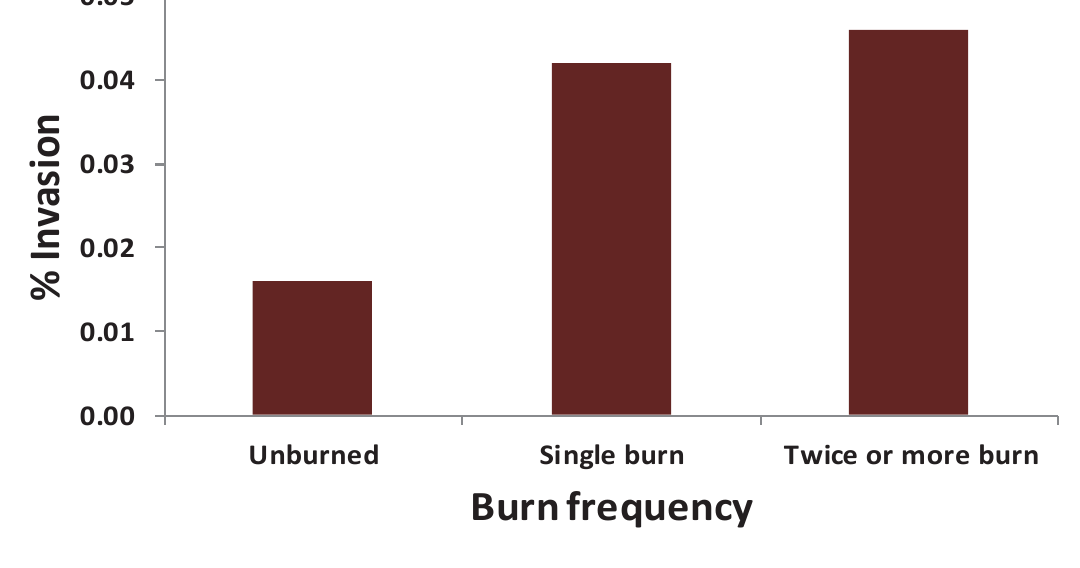
Figure 5. Relationship between Imperata cylindrica % invasion and burn frequency in Blackwater River State Forest.